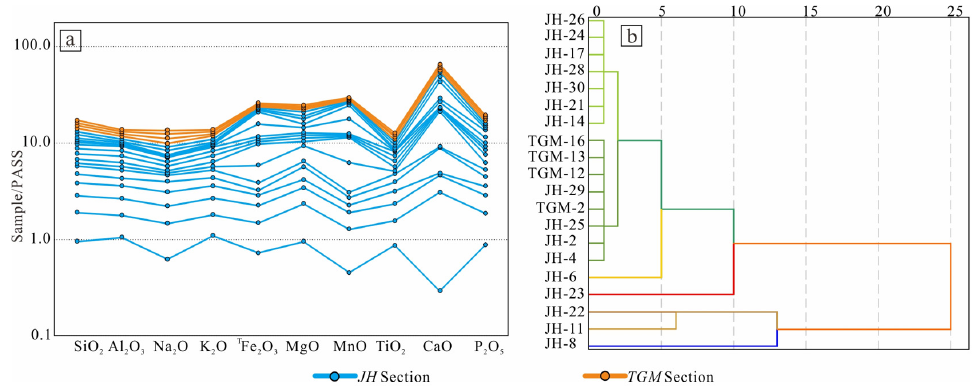
Figure 5. Characterization of the major elements of the Xu-3 Member in the JH and TGM sections (PAAS data from [48]). ( a ) PAAS standardization of fine-grained sedimentary rocks in the Xu-3 Member; ( b ) Cluster analysis of major elements of fine-grained sedimentary rocks in the Xu-3